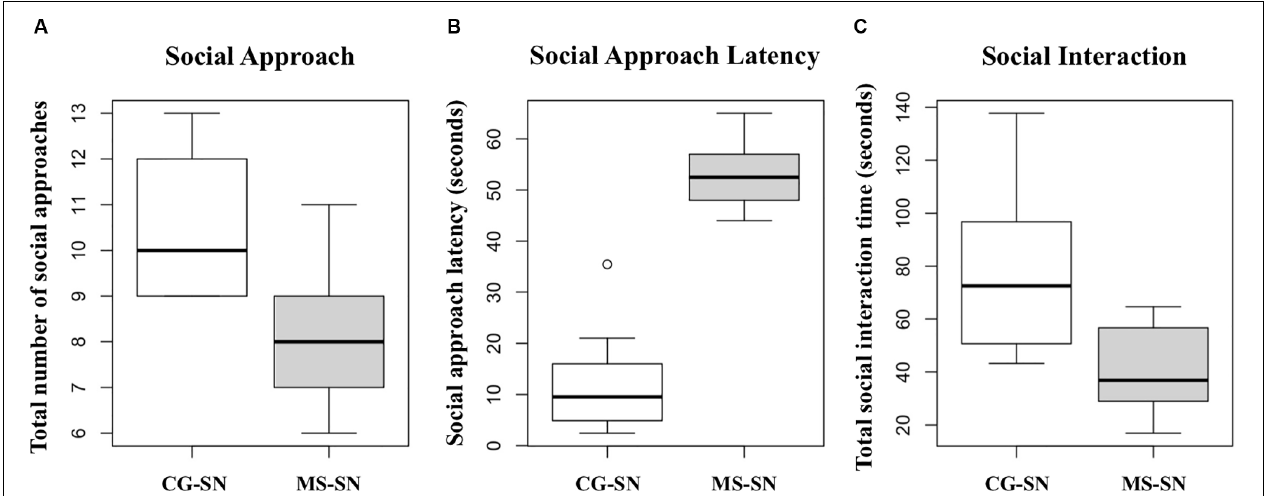
FIGURE 3 | Boxplots for the data of: (A) Total number of social approaches. (B) Social approach latency. (C) Total social interaction time. CG-SN ( n = 10), Control Subjects-Social Novelty group; MS-SN ( n = 10), Maternal Separation-Social Novelty group. Student’s t- test was used to compare behavioral data between groups CS-SN and MS-SN. Significance for all analyses was defined as p < 0.05.